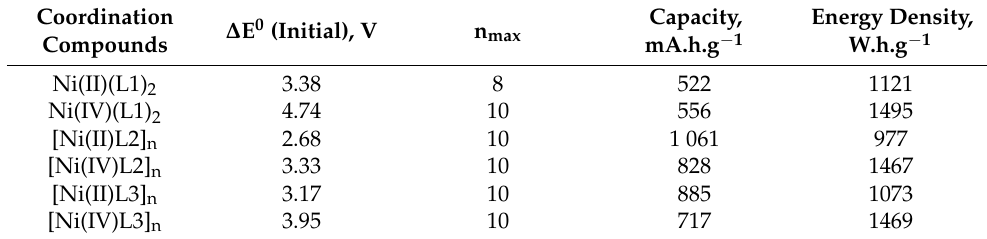
Table 5. Summarized electrochemical parameters of the designed constructs.